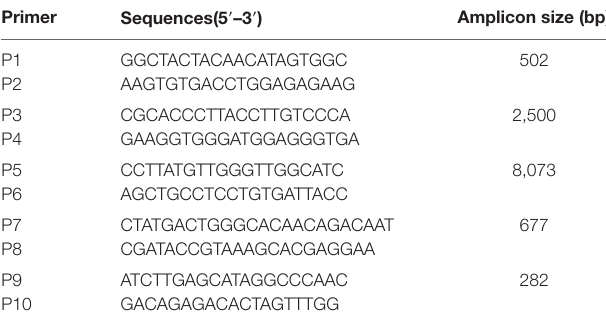
TaBle 1 | Primer pairs used for conventional